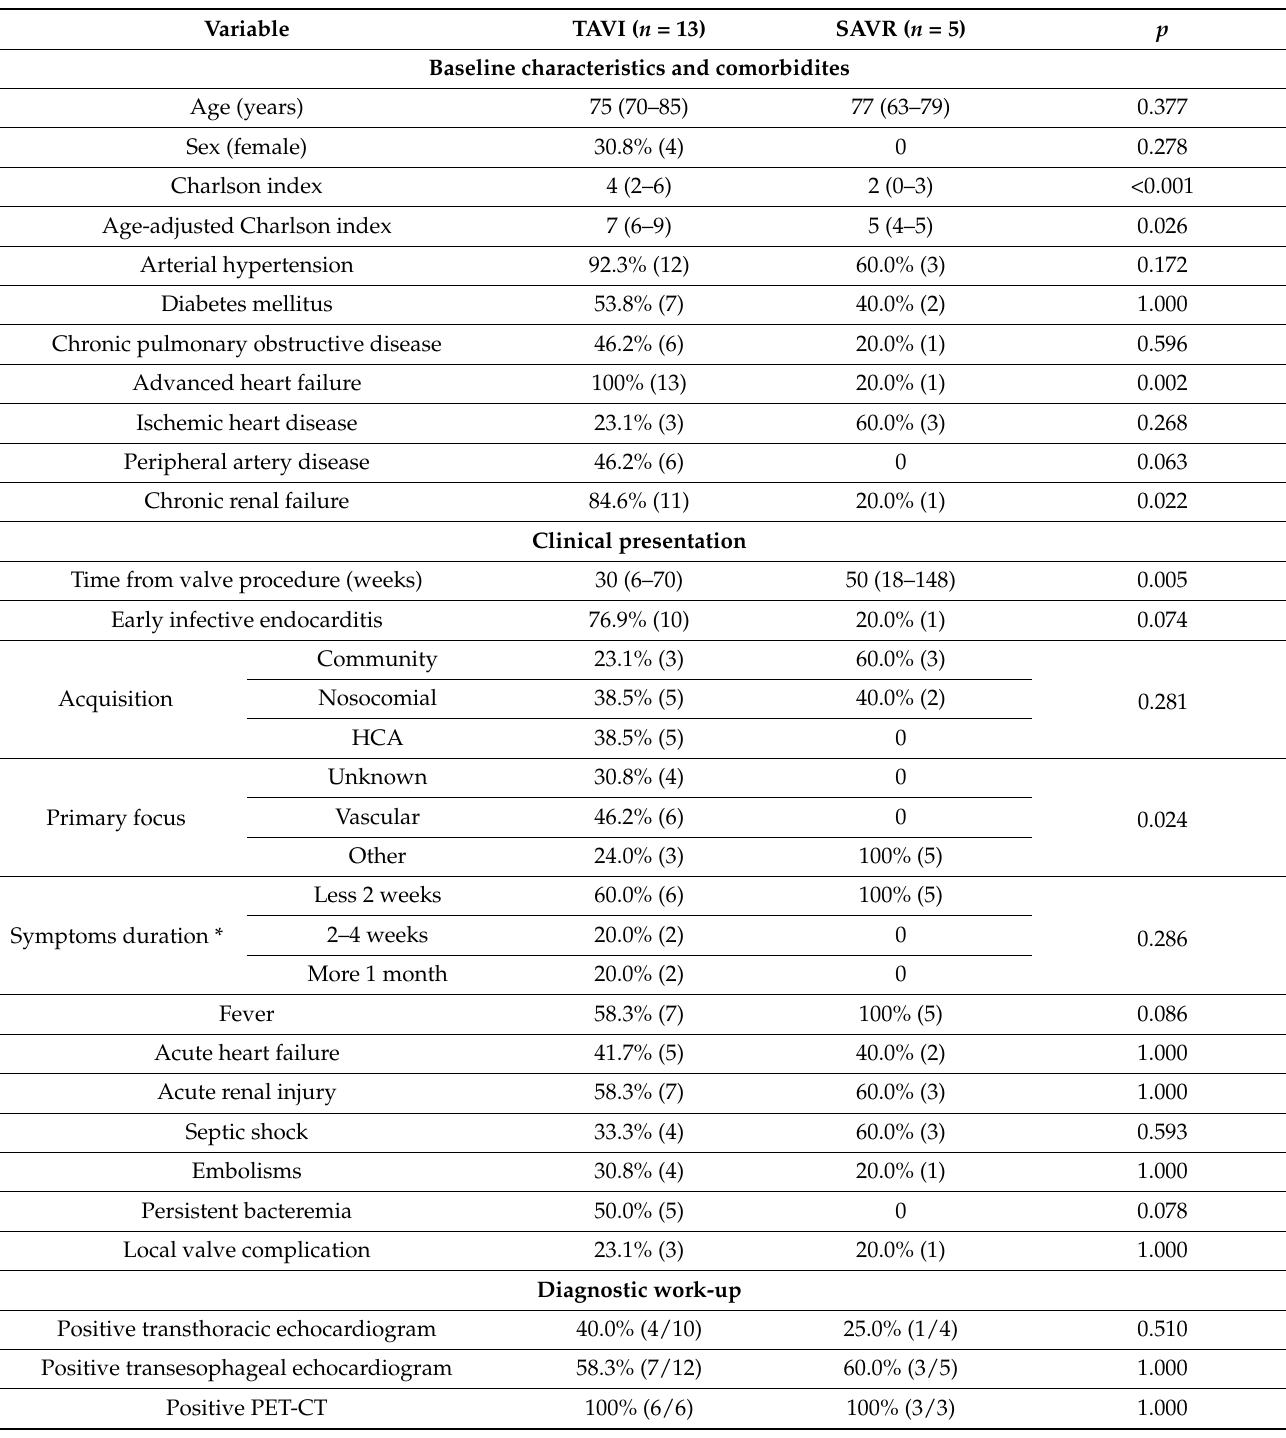
Table 4. Baseline characteristics, clinical presentation, diagnostic work-up, and outcomes of IE in patients with TAVI versus